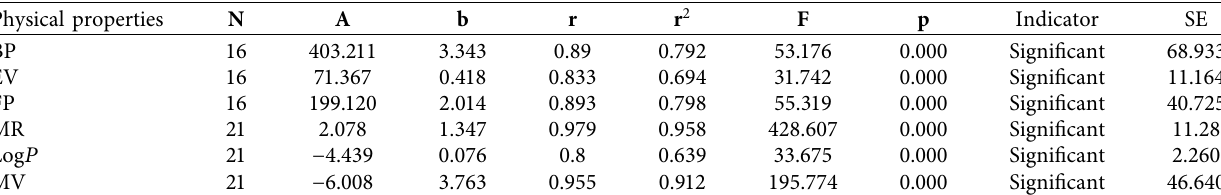
Table 6: Statistical specifications for the linear model of RR ( G ) .